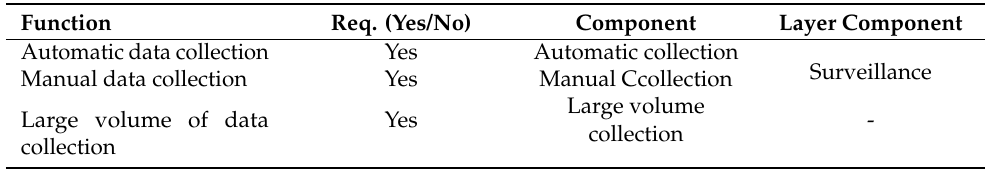
Table 3. Application of CTI Reference Model: Surveillance Layer.